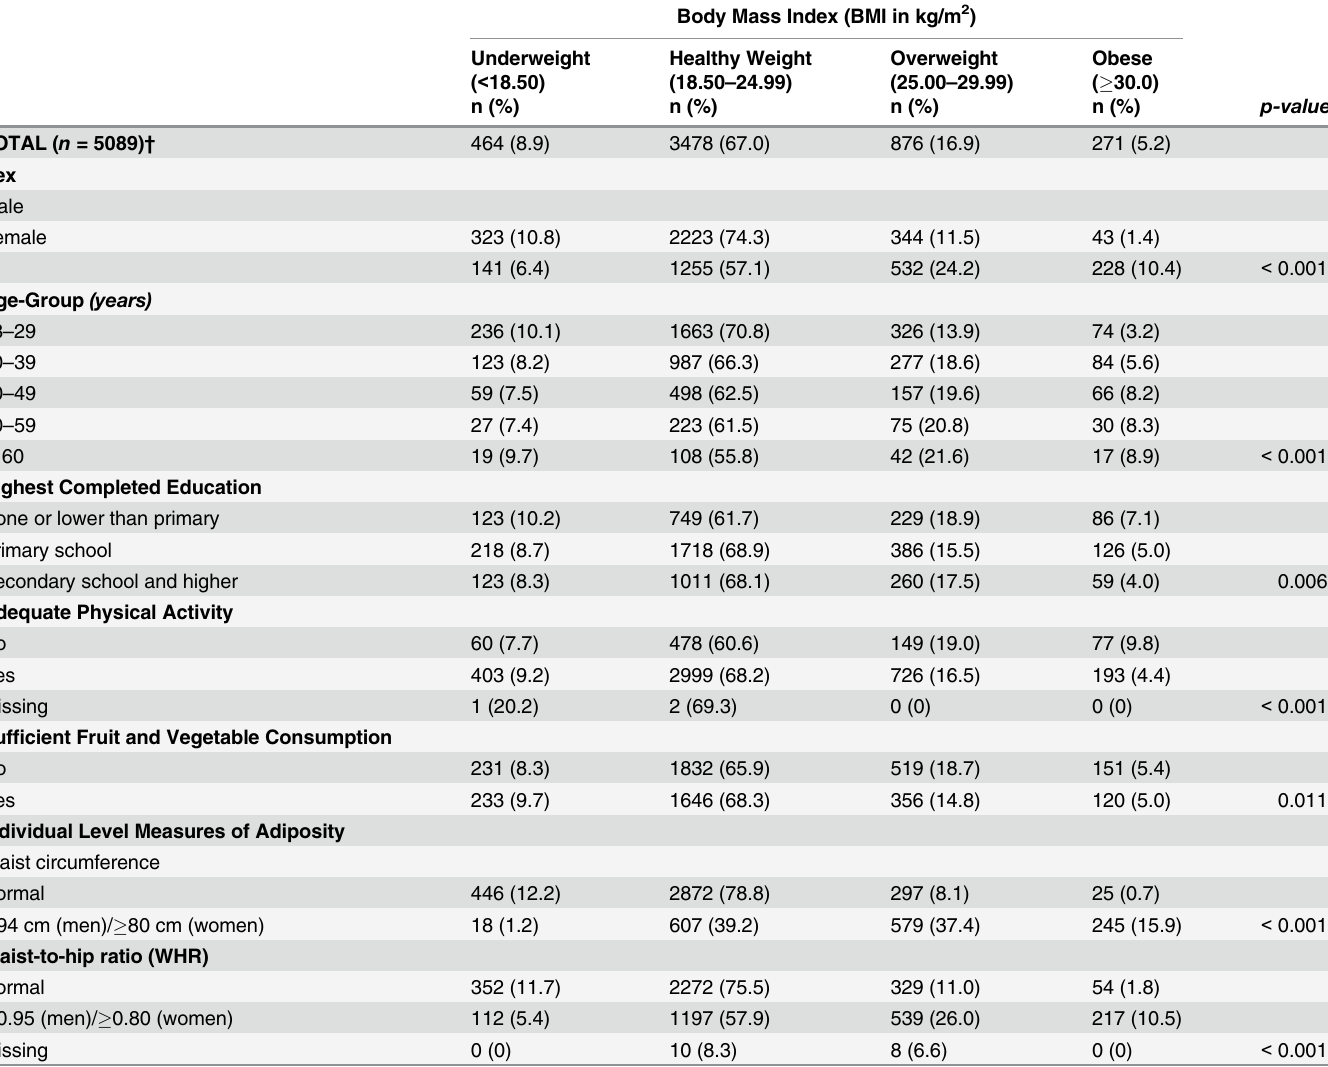
Table 3. Body mass index by individual characteristics for all adults 18 years and older, Nairobi